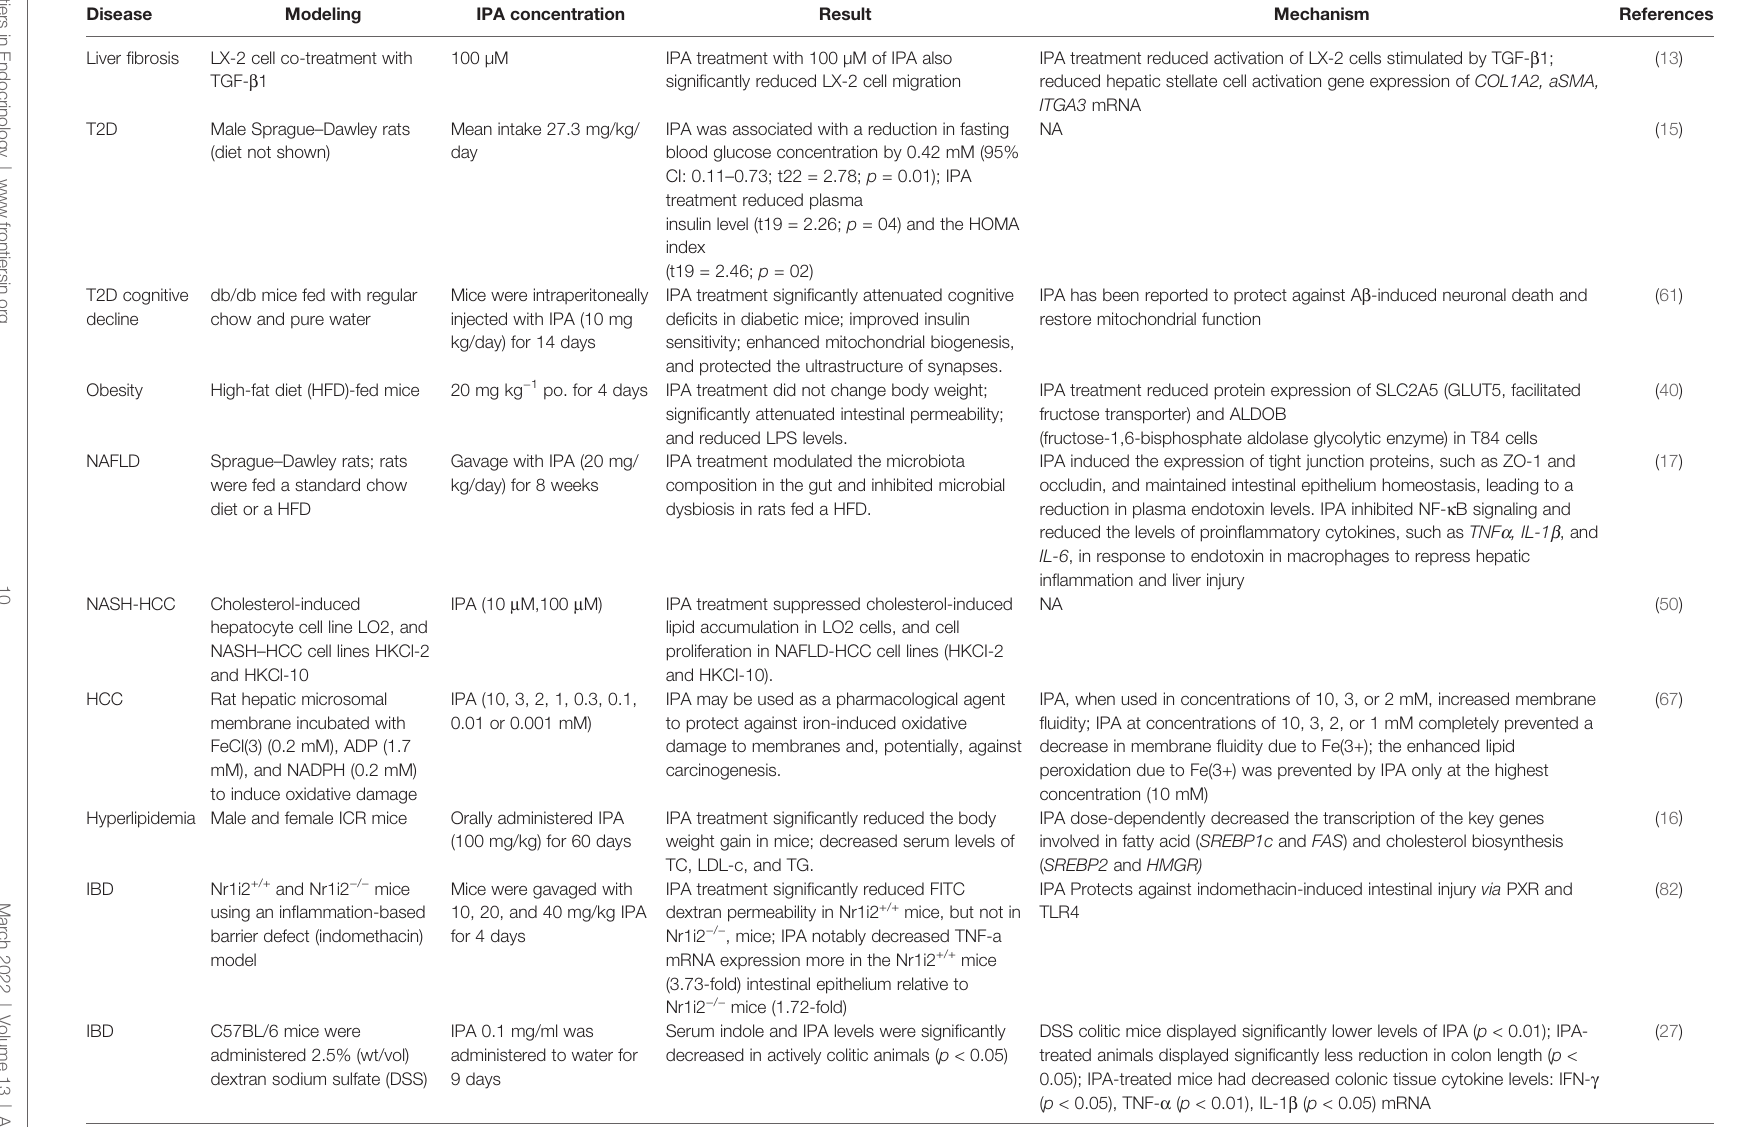
TABLE 2 | Bene fi ts of IPA in metabolic